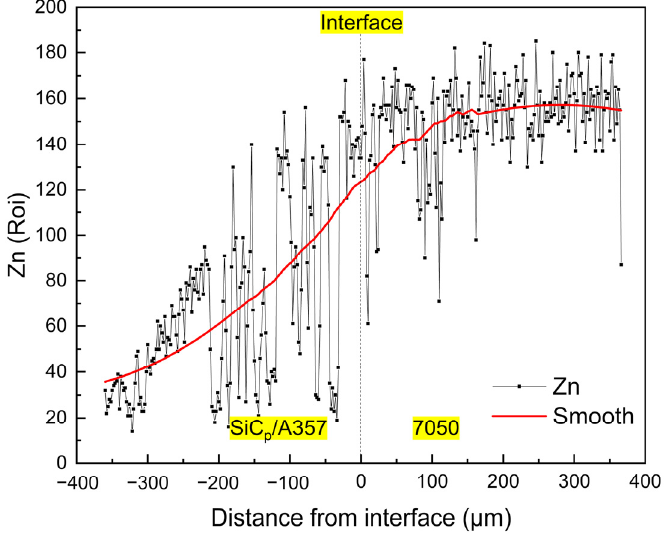
Figure 20. Concentration variation of Zn element across the solid–liquid bonding interface in T6 status.